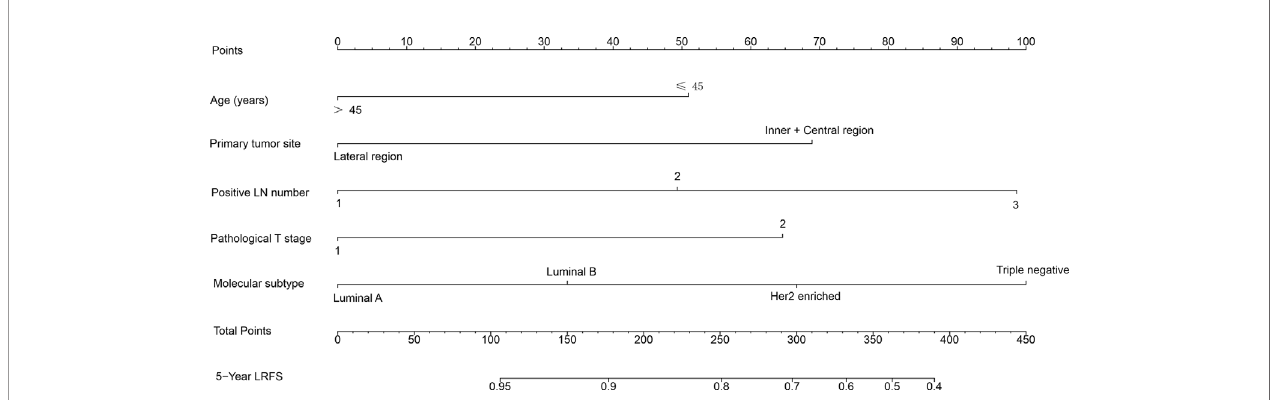
FIGURE 1 | Nomogram predicting 5-year locoregional recurrence-free survival (LRFS) for patients with pT1-2N1M0 breast cancer. The nomogram assigns a point to each variable value according to its contributions. The sum of these numbers is located on the total points axis and can be translated to predicted probability of LRFS for a patient.